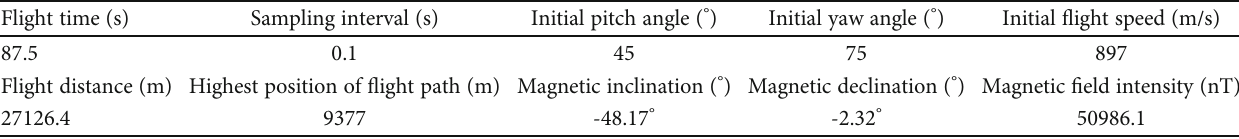
Table 1: Simulation parameters.